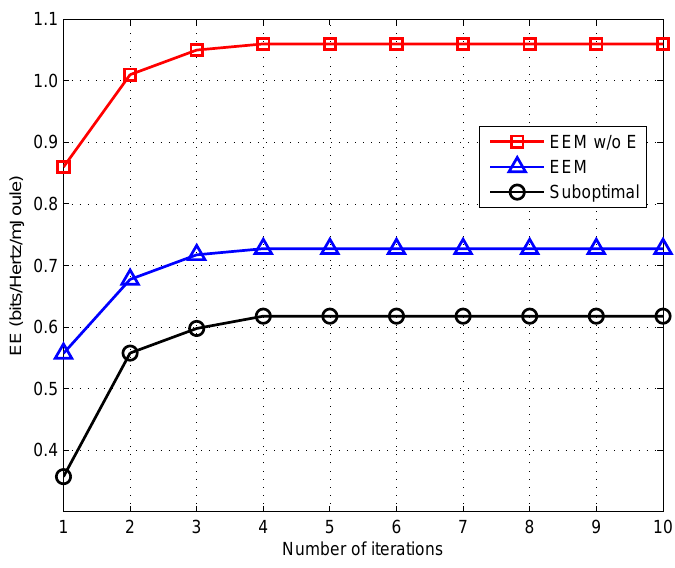
Figure 2. Convergence behavior of the proposed algorithms. EE: energy efficiency; EEM w/o E: EEM algorithm without an eavesdropper.